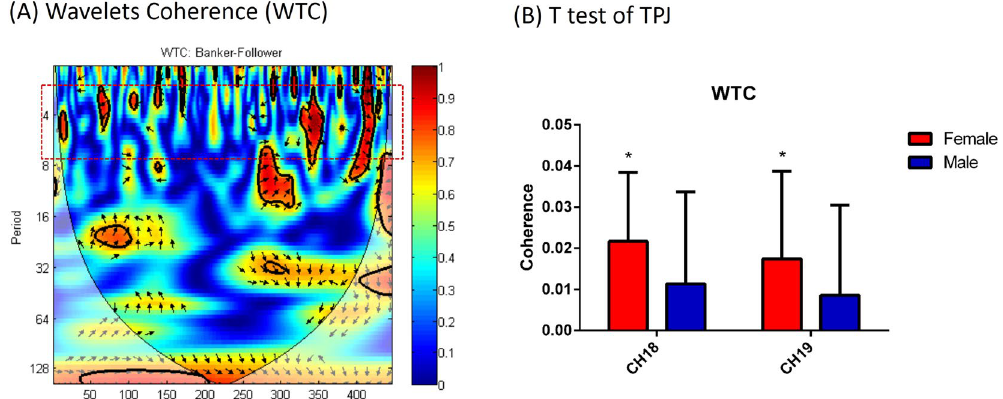
Figure 3. ( A ) Example of synchronization indicated by coherence. Wavelet transform coherence (WTC) based on oxy-Hb signal from channel 18 from banker and follower in the same dyad. The higher coherence encoded by red is in the task frequency band (2–7 s). ( B ) One-sample t-test of interpersonal brain synchronization in CH18 and CH19, respectively. Female banker–follower dyads showed significant synchronization in these two channels ( * P < 0.05). Error bars indicate standard errors. (FDR corrected).